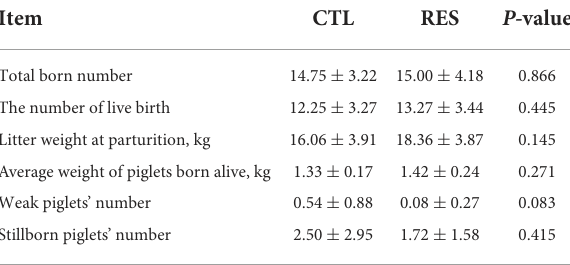
TABLE 1 The effect of RES on the reproductive performance of